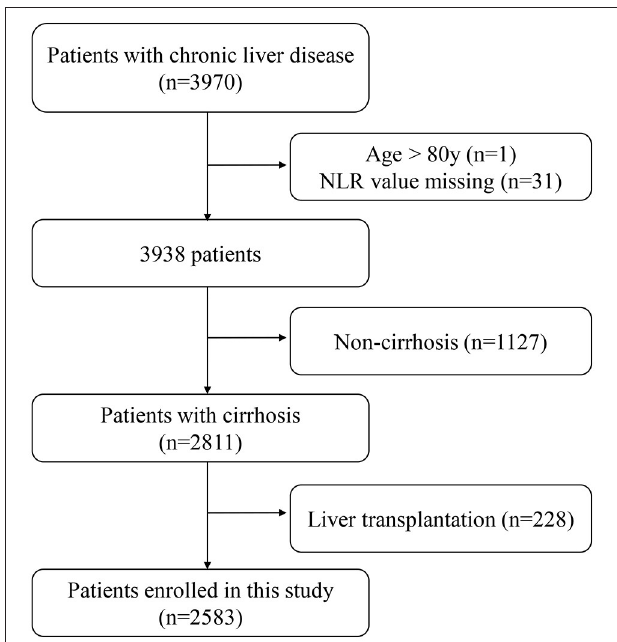
FIGURE 1 | Flow chart of patients enrolled in this